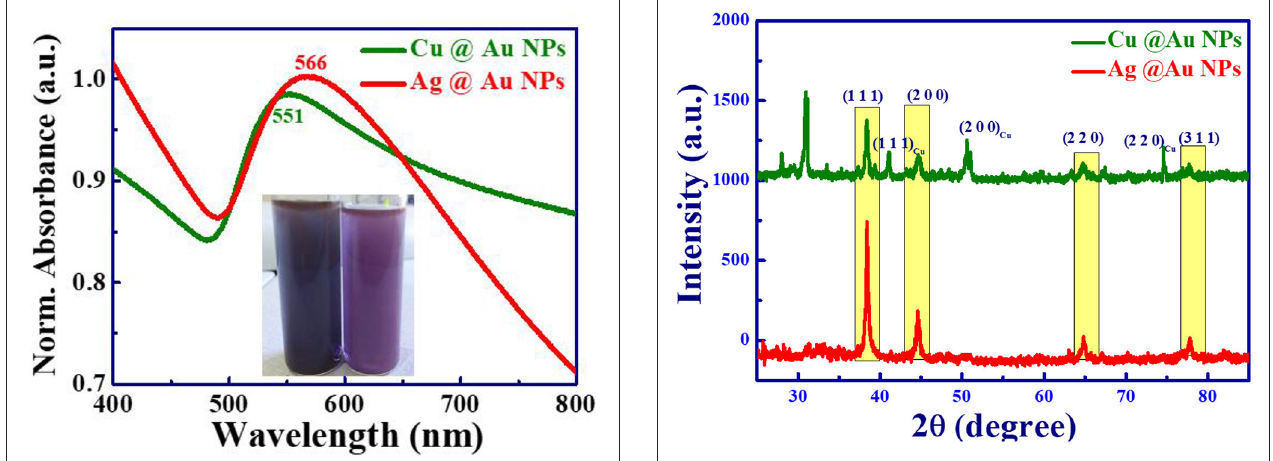
(2 0 0), (2 2 0) and (3 1 1). Due to the similarities in lattice constants of Ag and Au [Au (0.40786 nm) and Ag (0.40862